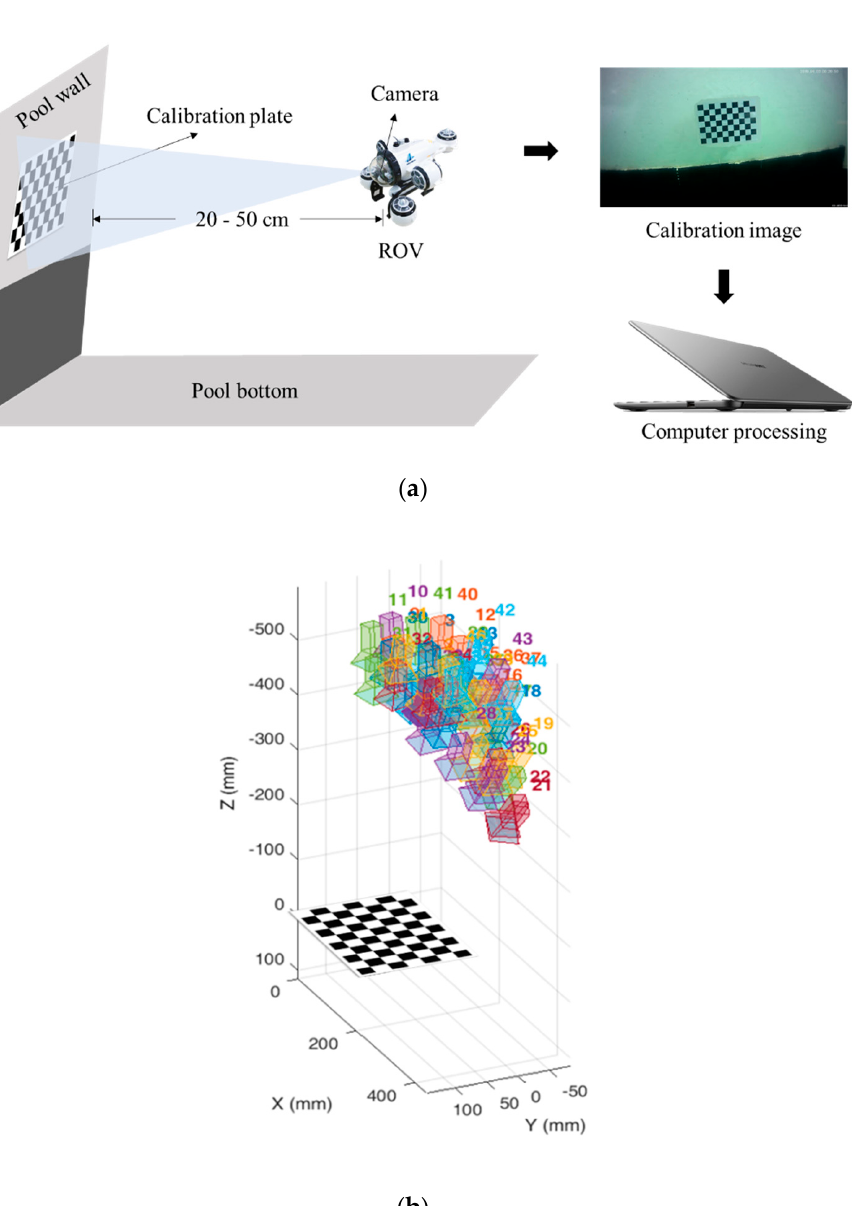
Figure 3. Camera calibration. ( a ) Schematic diagram of the process of acquiring calibration images by the ROV in the pool; ( b ) The position of the camera relative to the calibration plate during image acquisition.